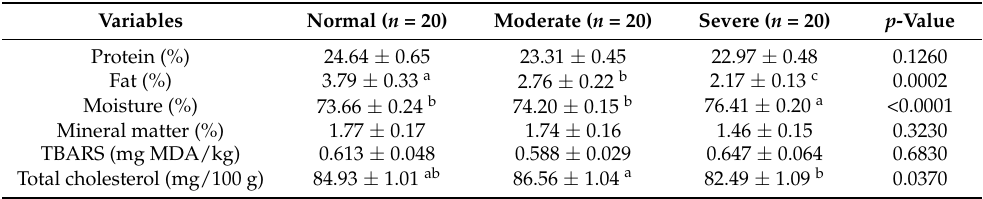
Table 5. Mean values and standard deviation of crude protein, fat, moisture and mineral matter concentrations; lipid oxidation (TBARS) and cholesterol of breast meat from broilers affected by WBM and stored for 30 days at − 20 ◦